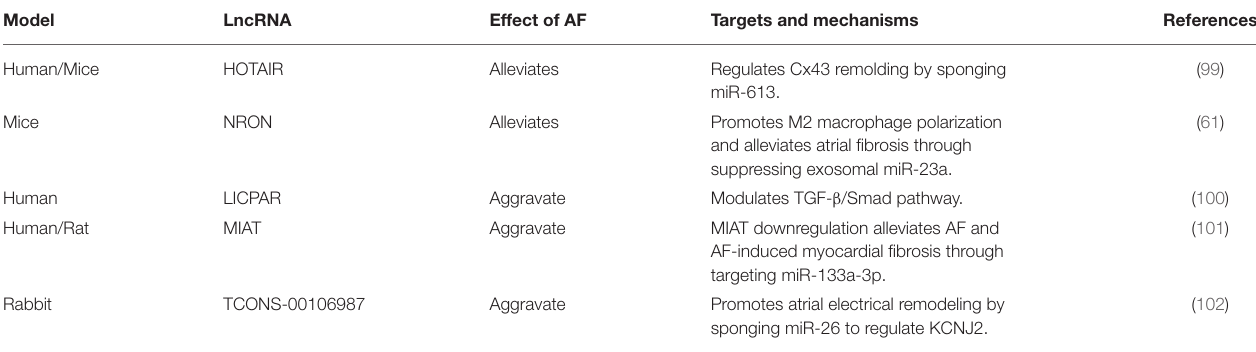
TABLE 2 | The lncRNAs and their functional mechanisms on